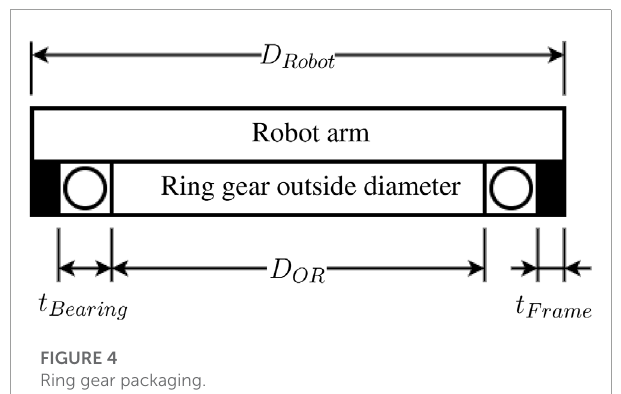
FIGURE 4 Ring gear